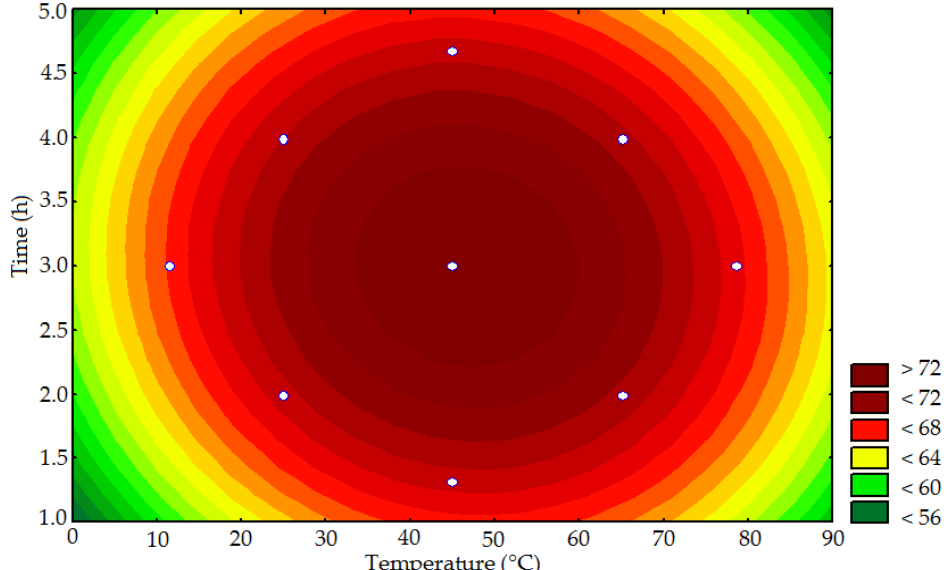
Figure 11. The contour plot dependency of activation time and temperature on CEC. Note: the white points in the image represent the lower and upper limits and the central point of the factors (time and temperature), including their critical points leading to a minimum and maximum CEC.